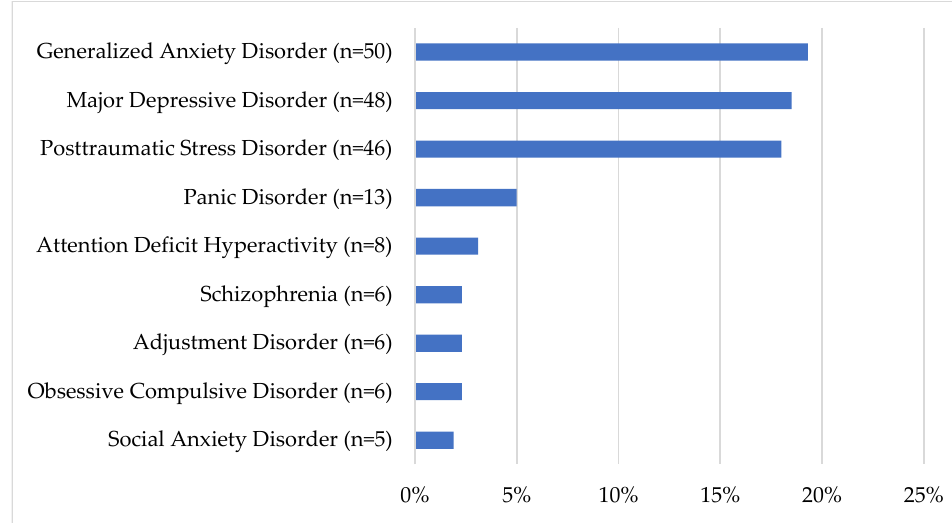
Figure 4. Prior diagnoses of mental disorders.